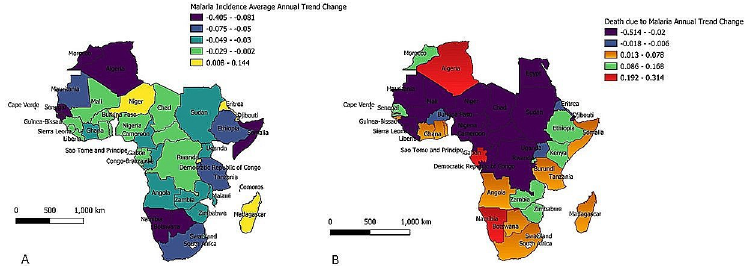
Fig 1. Spatial Distribution of Malaria (A) and Death due to Malaria (B) in Africa.